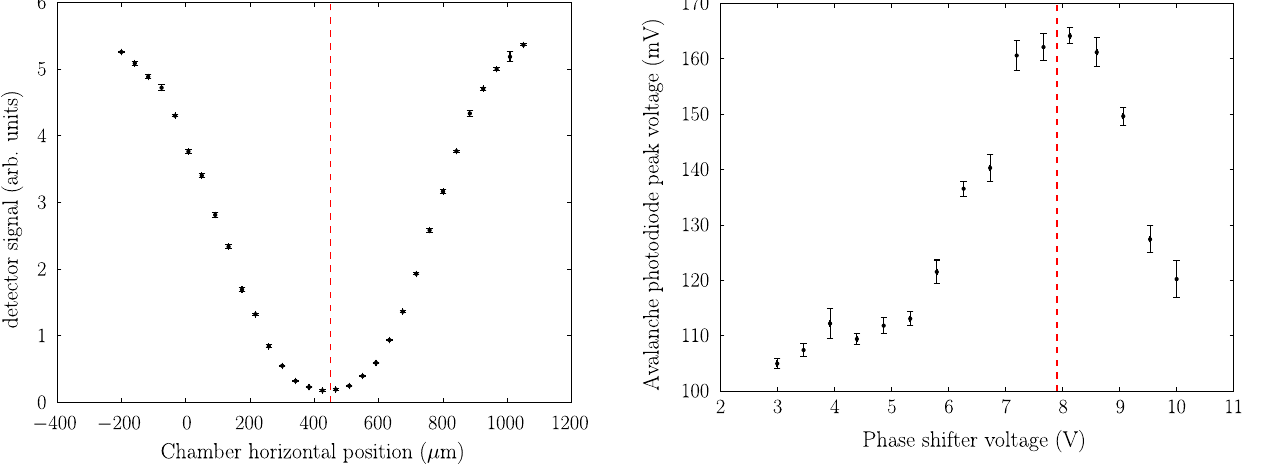
FIG. 14. Measured brehmstraahlung rate radiation as a function of horizontal chamber position with the OTR screen at the laser focus reference position. The red dashed line shows the chosen alignment position.